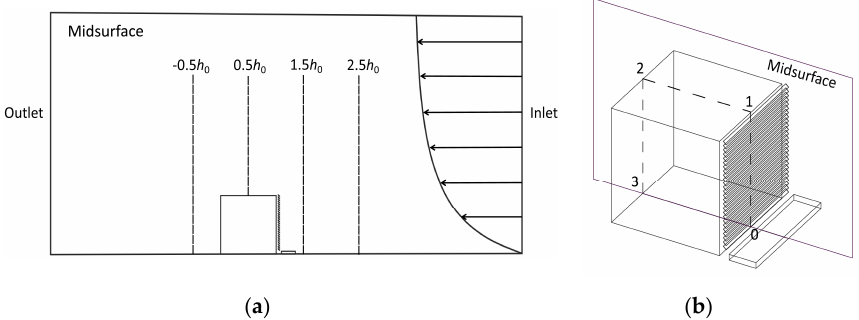
Figure 3. Measurement lines on the central plane of the studied building for ( a ) velocity U ; and ( b ) wind pressure coefficient C p .